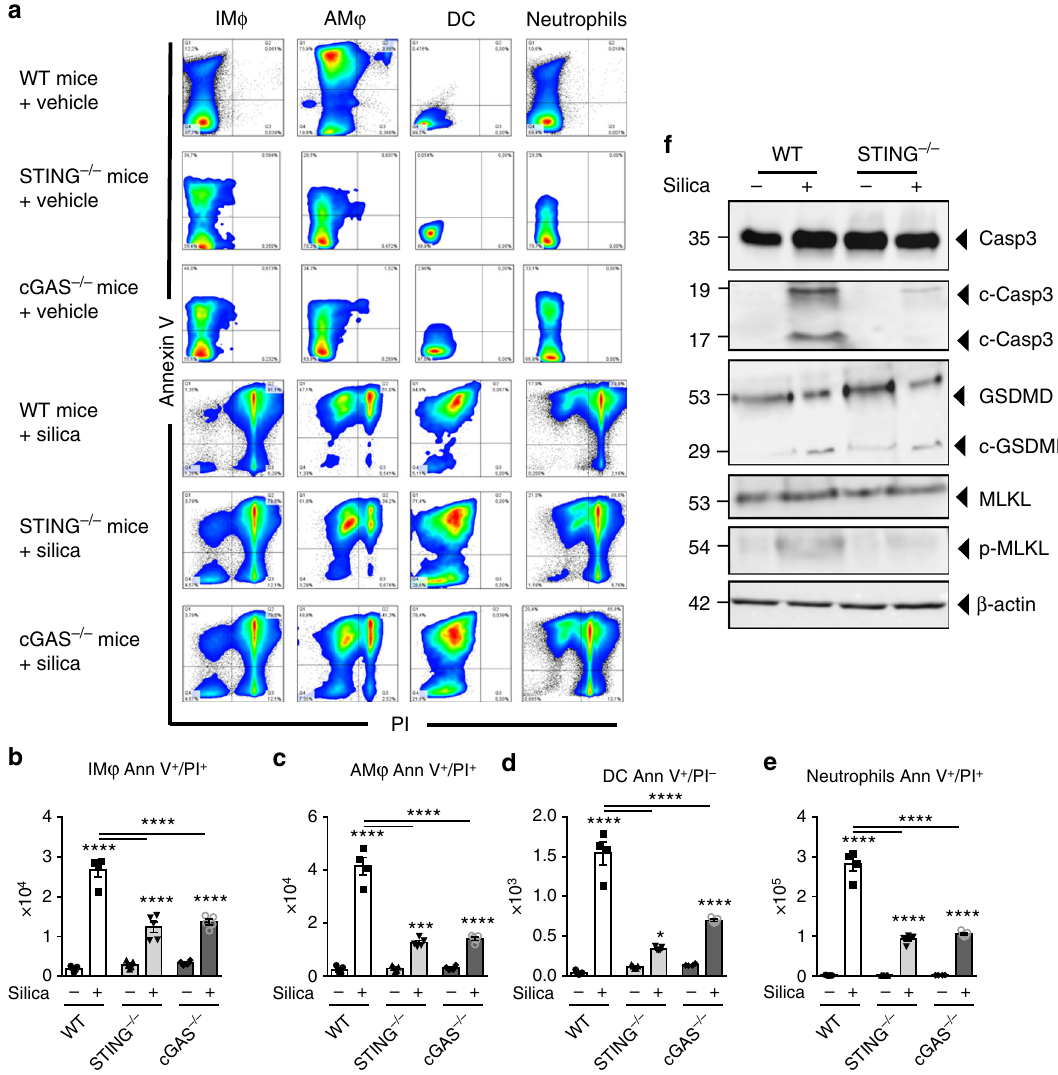
Fig. 4 Reduced silica-induced in fl ammatory cell death in the absence of cGAS/STING. Silica microparticles (1 mg/mouse, i.t.) or saline vehicle were administered in WT, STING − / − , and cGAS − / − mice and the different parameters were analyzed on day 7, as in Fig. 3. a Flow cytometry representative dot blots showing Annexin V/PI staining of F4/80 + CD11c – interstitial macrophages (IM), F4/80 + CD11c + alveolar macrophages (AM), CD11c + F4/80 − dendritic cells (DC), and Ly6G + F4/80 – neutrophils among CD45 + CD11b + cells in WT, STING − / − , and cGAS − / − mice. Bargraphs of the Annexin V/PI-stained cells among b interstitial macrophages, c alveolar macrophages, d DCs, and e neutrophils, expressed as absolute cell number per lung. f Immunoblots of caspase 3, cleaved caspase 3, gasdermin D, MLKL, and phospho-MLKL in the lung of WT and STING − / − mice with β -actin as a reference. * p < 0.05, *** p < 0.001, **** p < 0.0001 (Kruskal – Wallis test followed by Dunn post test). Data are presented as mean ± SEM and are representative of two independent experiments ( a – e : mice per group: n = 5 (WT NaCl), n = 4 (WT silica), n = 5 (STING − / − NaCl), n = 5 (STING − / − silica), n = 4 (cGAS − / − NaCl), n = 5 (cGAS – / – silica)). Immunoblots are representative of n = 6 samples from two independent experiments ( f ). Each symbol represents an individual mouse. Source data are provided as a Source Data fi